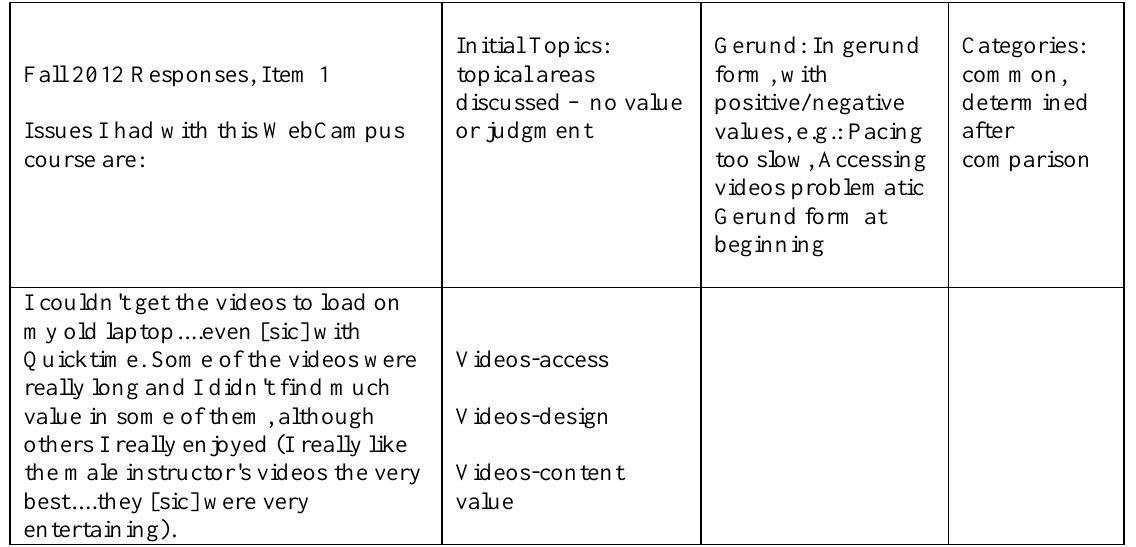
Figure 1 . Response table with verbatim response and initial topics